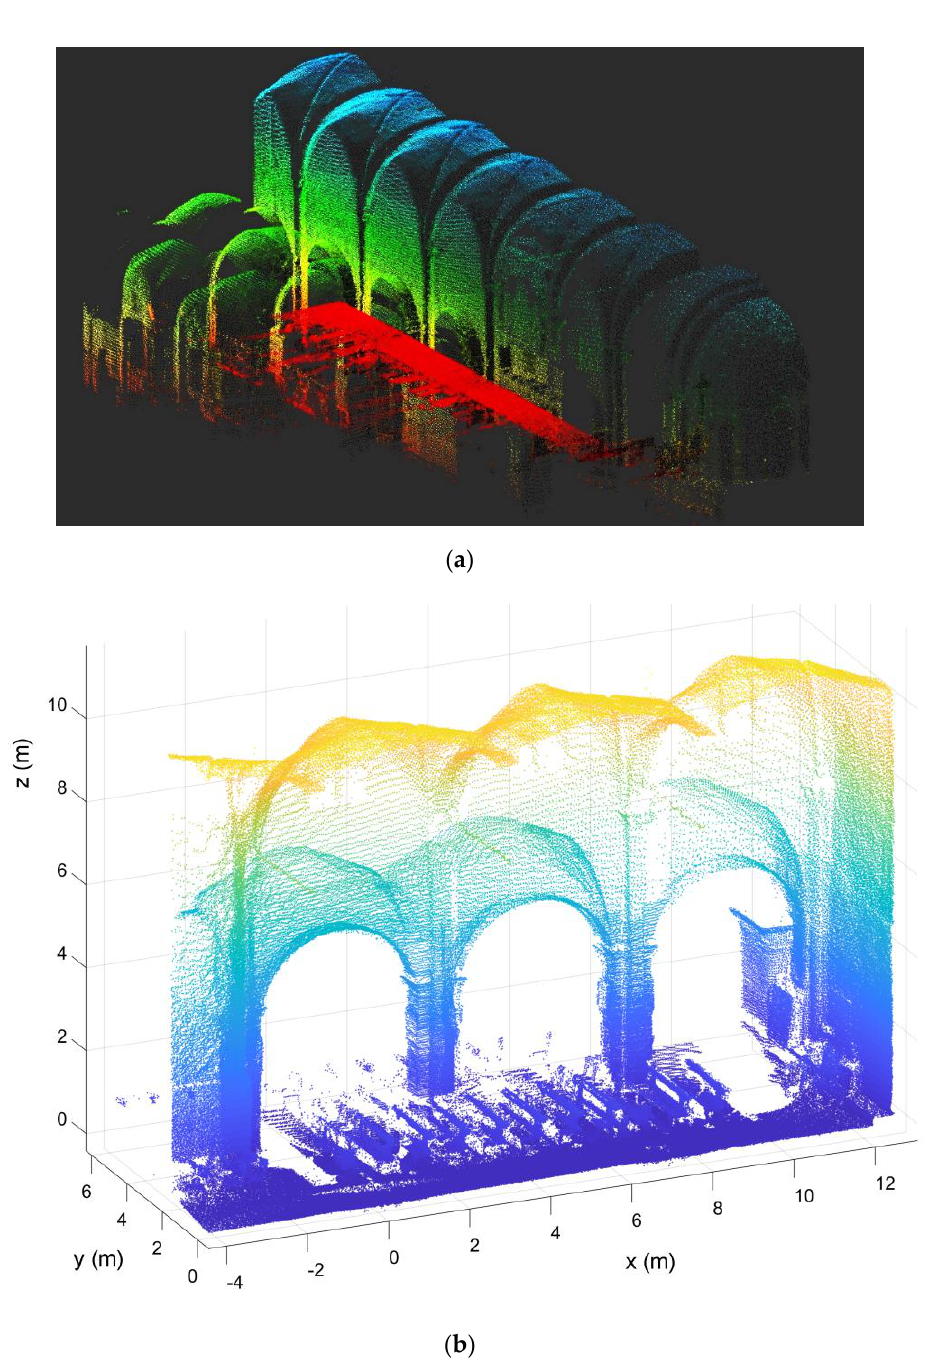
Figure 2. Church of St. Bassiano: point cloud light detection and ranging (LiDAR) survey: ( a ) the complete survey and ( b ) detailed view of the first three bays, toward the façade.